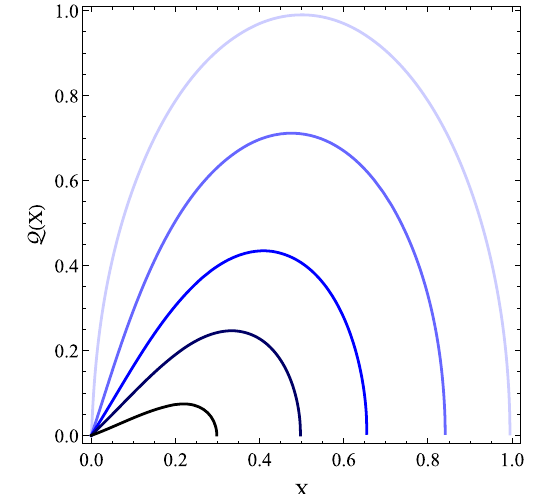
Fig. 1 Curves from up to down belongs to β = 0 . 01, 0 . 3, 0 . 6, 0 . 8, 0 . 96. This shows that thickness of the disk seriously stabilizes the